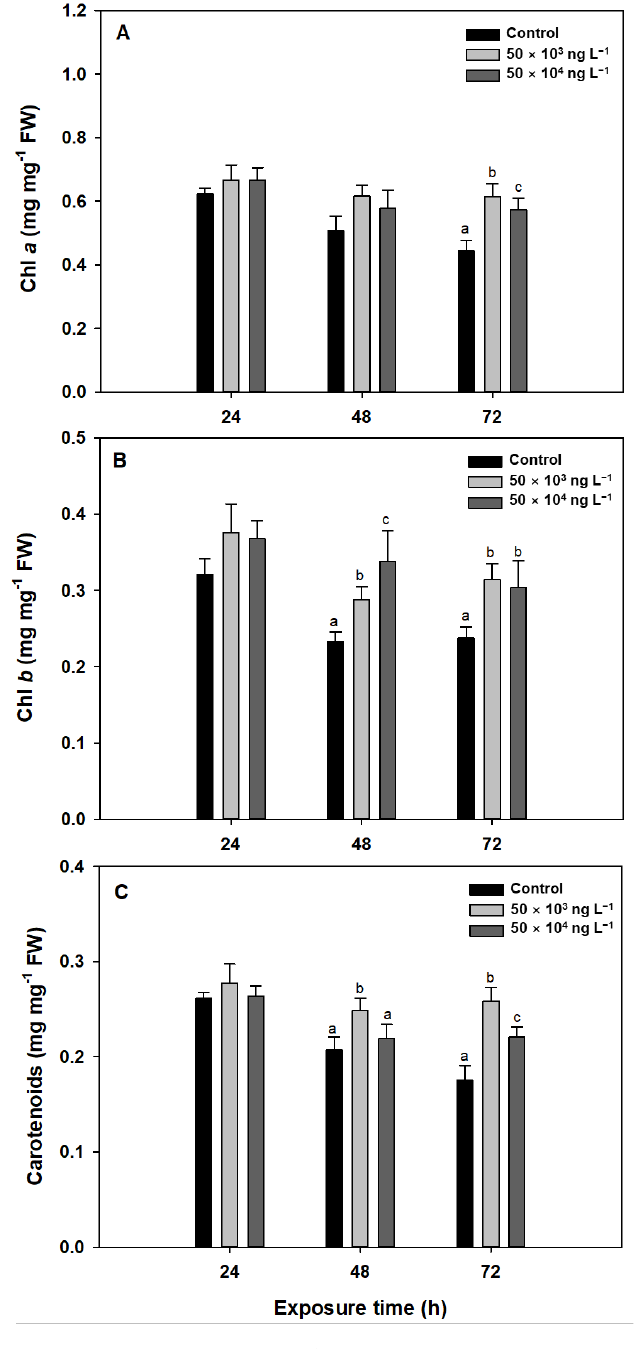
Figure 2. Levels (all in mg mg −1 FW) of chlorophyll a ( A ), chlorophyll b ( B ), and carotenoids ( C ) in Lemna minor exposed to diuron (50 × 10 3 and 50 × 10 4 ng L −1 ) for 24, 48, and 72 h. Data represent means of three replicates. Standard deviations are indicated by error bars. Different letters indicate statistically significant differences at p < 0.05 (one-way ANOVA, LSD). Absence of a letter in a column indicates no statistical